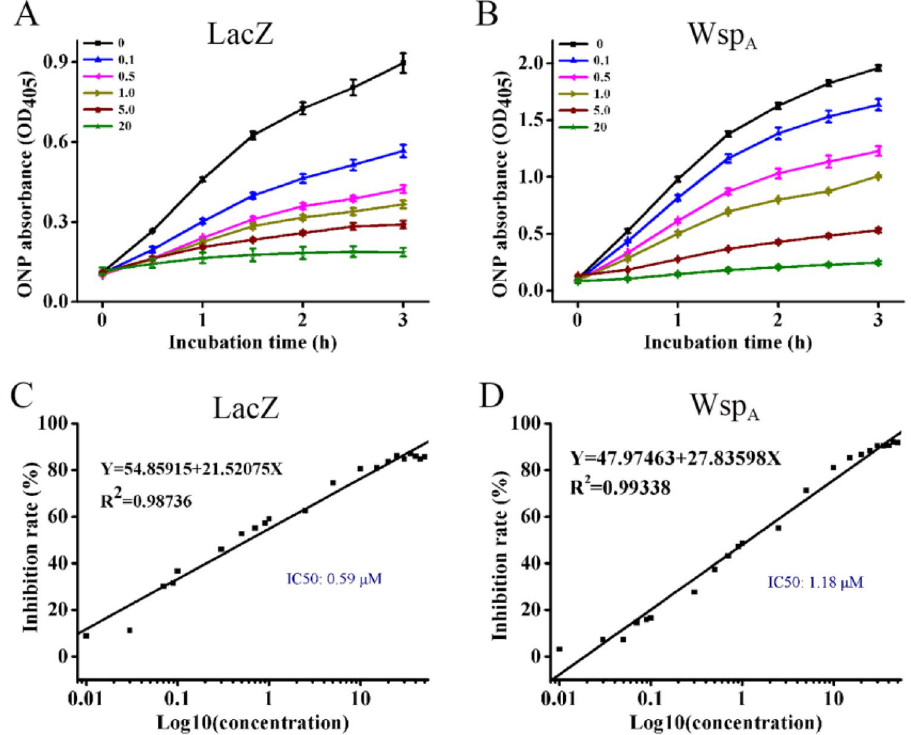
Figure 4. The inhibitory effects of GBS on the activities of Nf-LacZ and Wsp A . ( A , B ), the galactosyl hydrolytic reactions of Nf-LacZ and Wsp A in presence of different concentrations of GBS, respectively. GBS concentration: 0 ~ 20 µM. The absorbance of the reaction product ONP at 405 nm (OD 405 ) was detected. Data shown are means ± SD ( n = 3). ( C , D ), determination of the IC50 values of GBS inhibition on the activities of Nf-LacZ and Wsp A , respectively. GBS concentration ranged from 0.01 µM to 50 µM in the